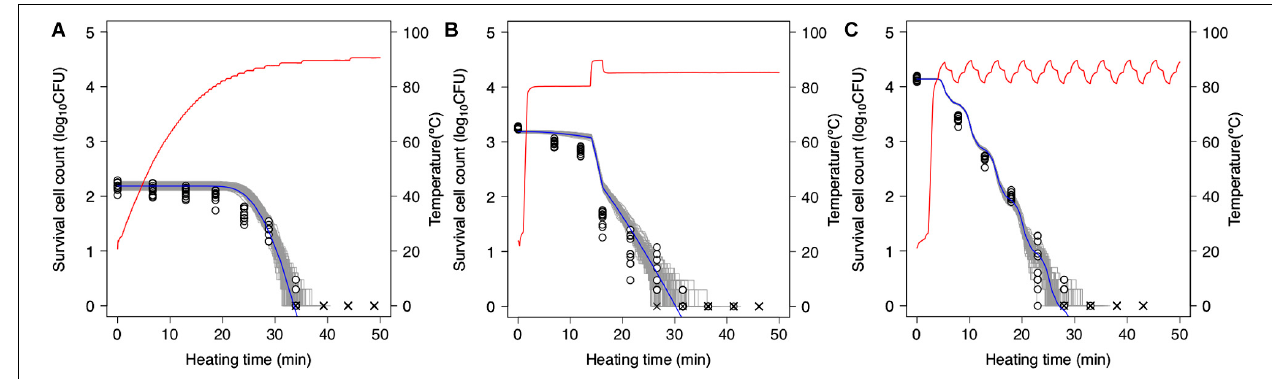
FIGURE 7 | Predictions of second-order Monte Carlo simulation (gray) and dynamic kinetic model (blue) and changes in 10 replicates of observed survival Bacillus simplex spore counts (points) under each temperature profile (red curve) of slow come-up heating in pH 6.5 (A) , bumpy heating in pH 6.3 (B) , and waving in pH 6.4 (C) . × represents no colonies were detected.